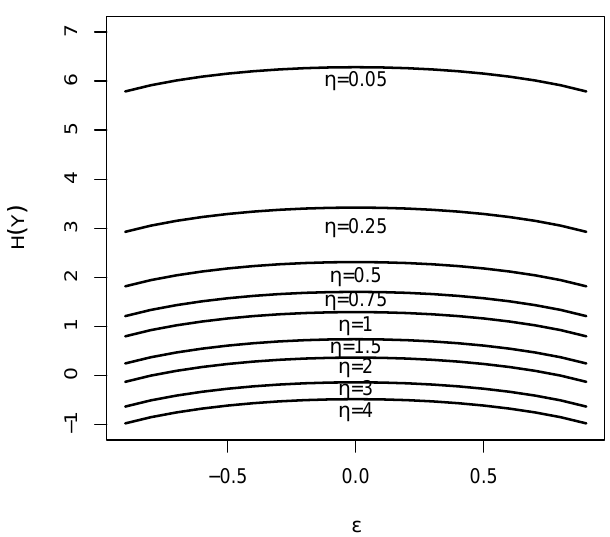
Figure 1. Shannon entropy of Skew-Reflected-Gompertz (SRG) distributions for ε ∈ ( − 1,1 ) and several values of η